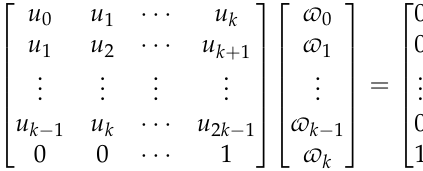
Figure 2. Framework of the SSR-ETM and ETM.